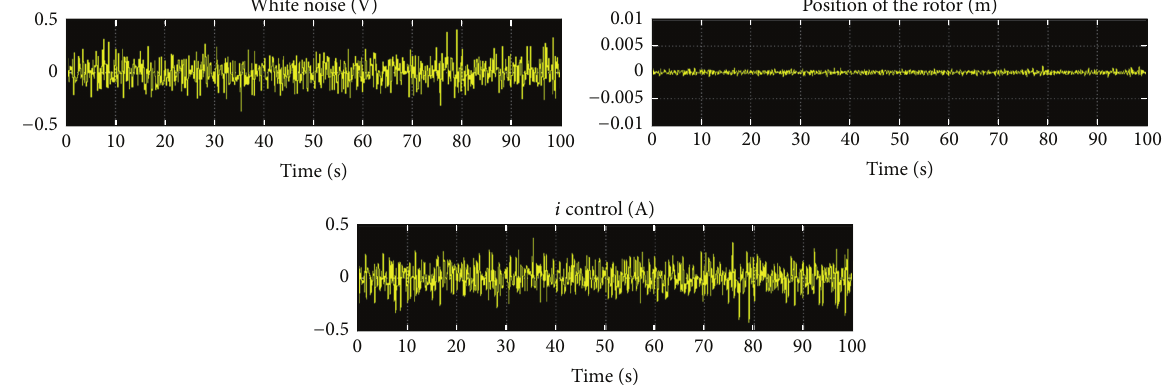
Figure 15: System response with PID controller with proportional gain of 319.0187, integral gain of 1273.2977, and differential gain of 7.2565 and white noise of 0.001